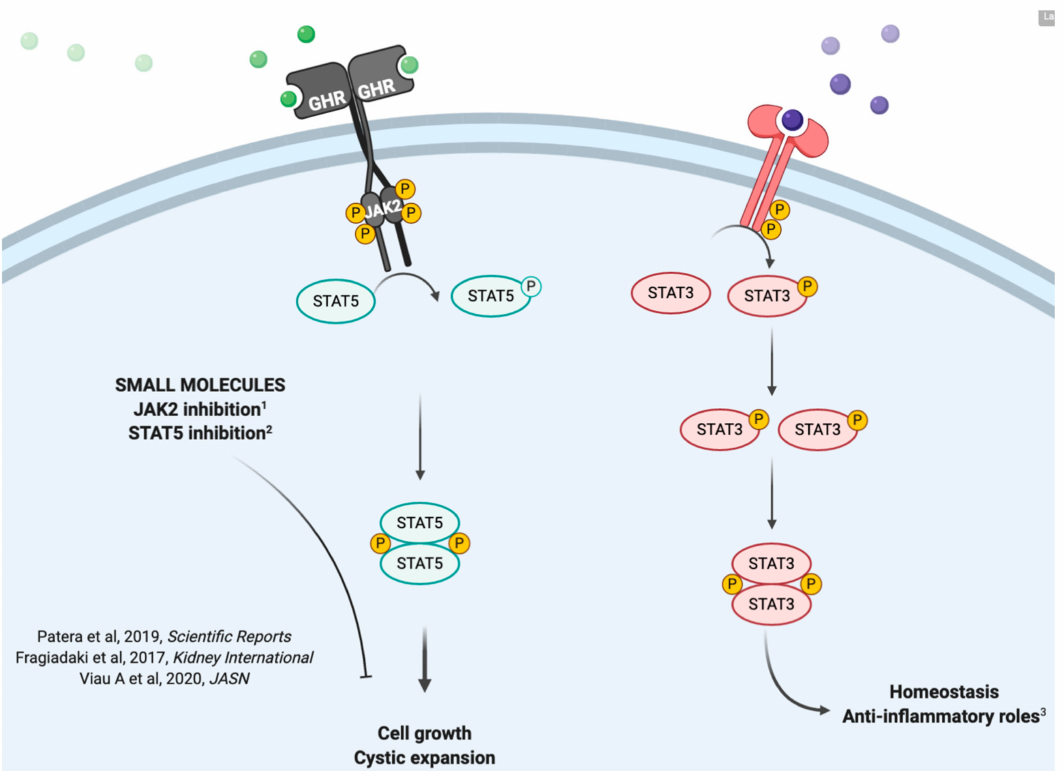
Figure 3. The role of JAK / STAT in cystic disease. The JAK / STAT family of evolutionarily conserved Janus Kinase and Signal Transducers and Activators of Transcription plays a key role in driving cystic growth in ADPKD. Specifically, JAK2-triggered STAT5 enhances cystic growth [20], and consistent with this, inhibition of JAK2 limits this [58]. On the other hand, STAT3, which can also be activated by JAK2, provides a homeostatic control, that when switched o ff leads to excessive renal inflammation